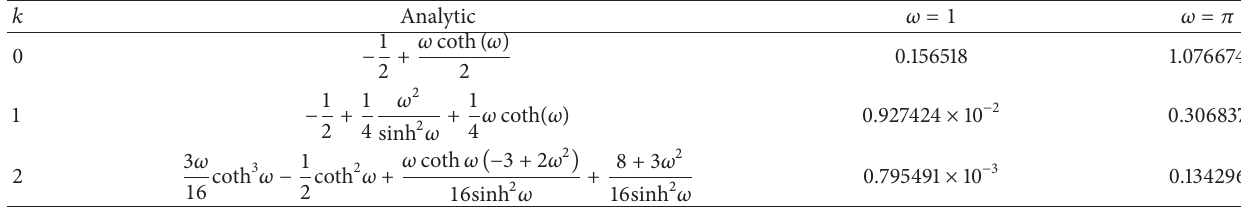
Table 1: The first few values of 𝜅(0,𝜅 + 1,𝜋 2 /𝜔 2 ) in (93). 𝑘